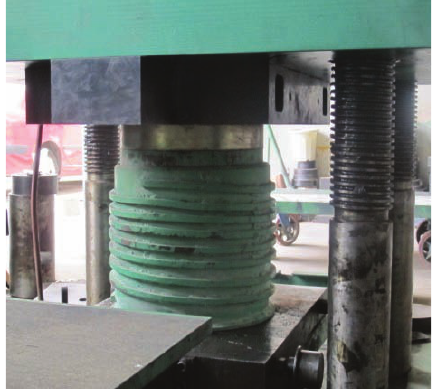
Figure 4: Loading procedure of model